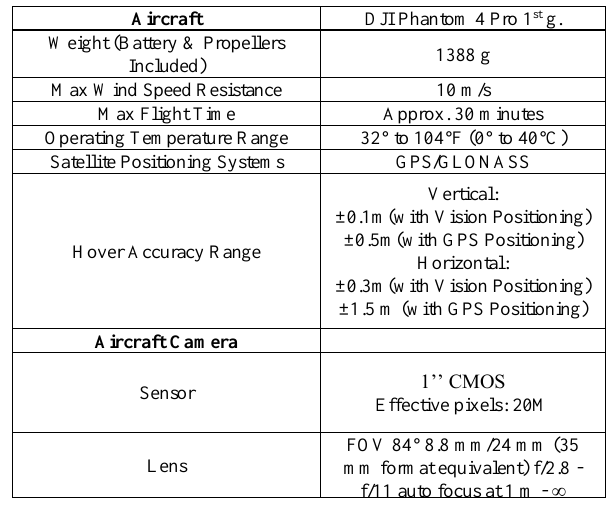
Table 2 . RPAS and camera characteristics